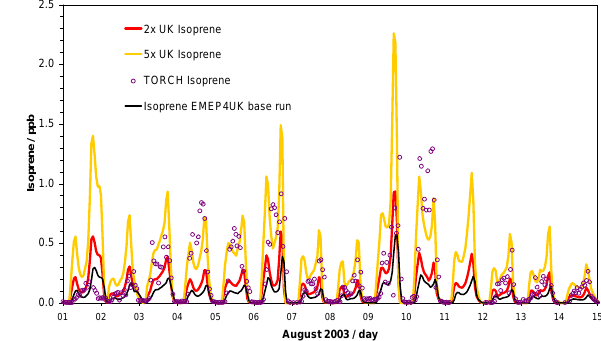
Fig. 10. Time-series of modelled (lines) and measured (cir- cles) hourly surface isoprene (ppb) during August 2003 at Writtle Figure 10: Time-series of modelled (lines) and measured (circles) hourly surface isoprene (ppb) during August 2003 at Writtle (TORCH).